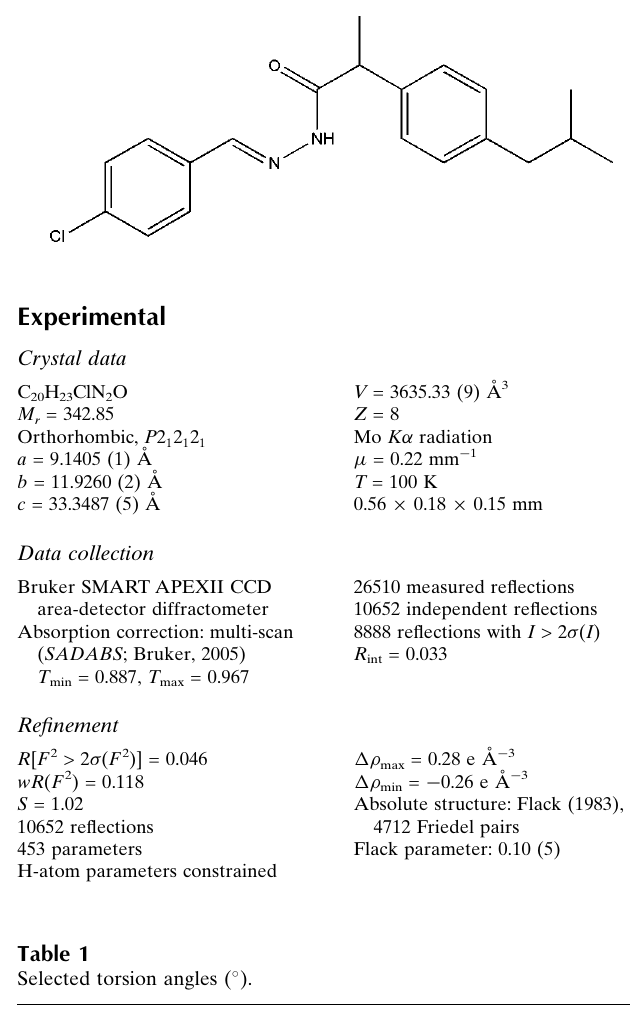
Selected torsion angles ( (cid:1) ).